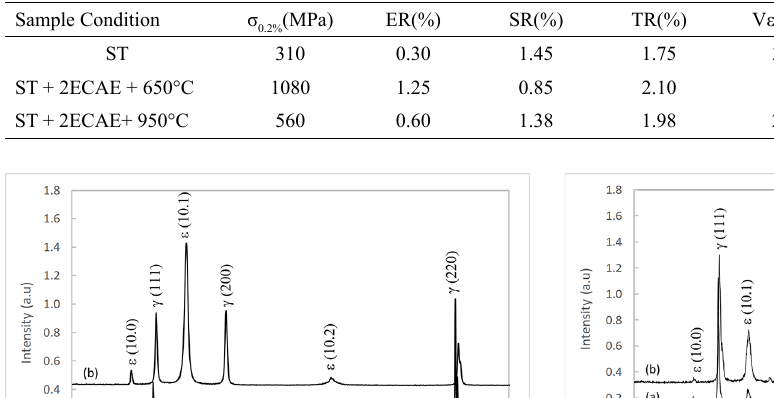
), elastic shape recovery (ER), shape memory recovery (SR), total shape recovery (TR), volume Table 2. Compressive yield stress (σ 0.2% fraction of thermally-induced martensite (Vε